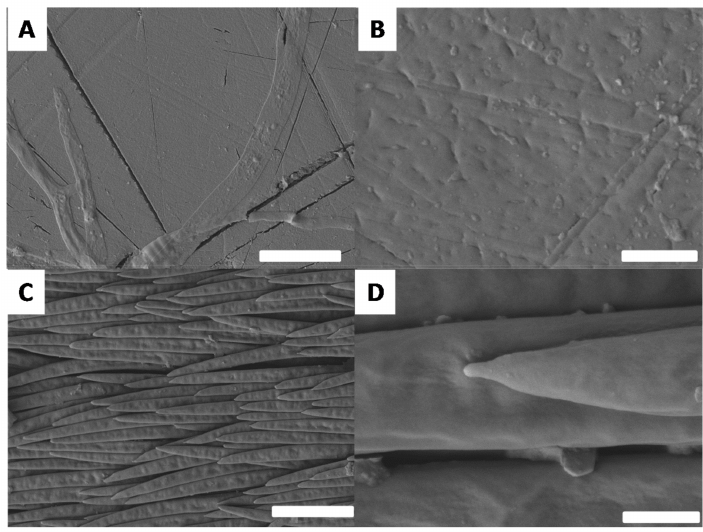
Figure 9. Scanning electron microscopy images showing the morphology of the G. orientalis ( A , B ) black and ( C , D ) white surfaces. Scale bars: 10 µ m ( A , C ); 1 µ m ( B , D ).